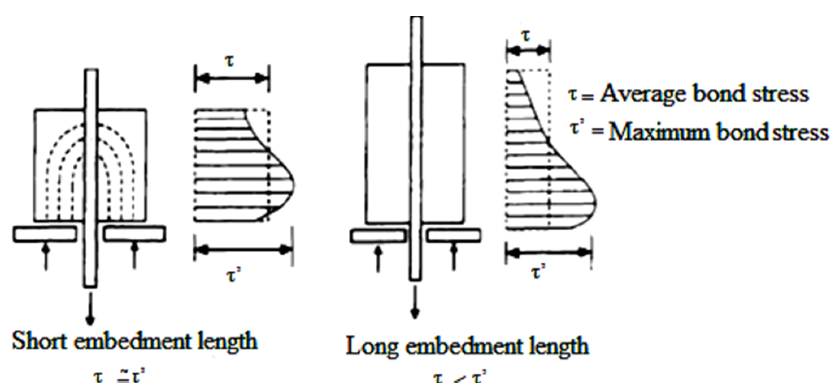
Figure 1. Schematic diagram for pullout test [20].